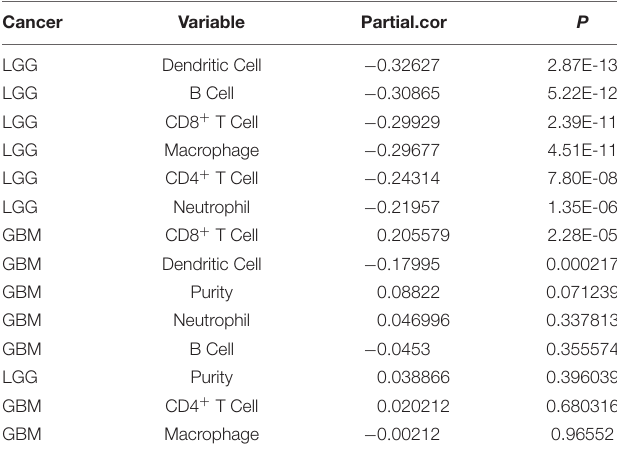
TABLE 2 | Univariate analysis of the correlation of MEG3 expression and immune infiltrates with OS in glioma.